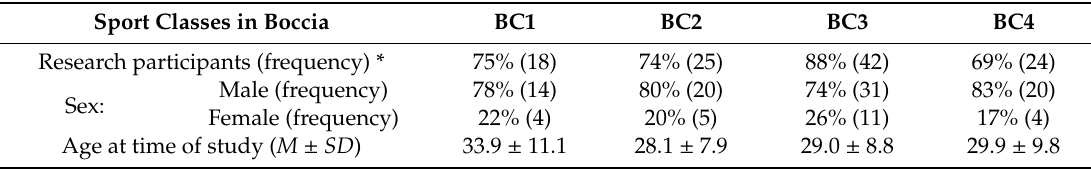
Table 1. Characteristics of boccia athletes by class